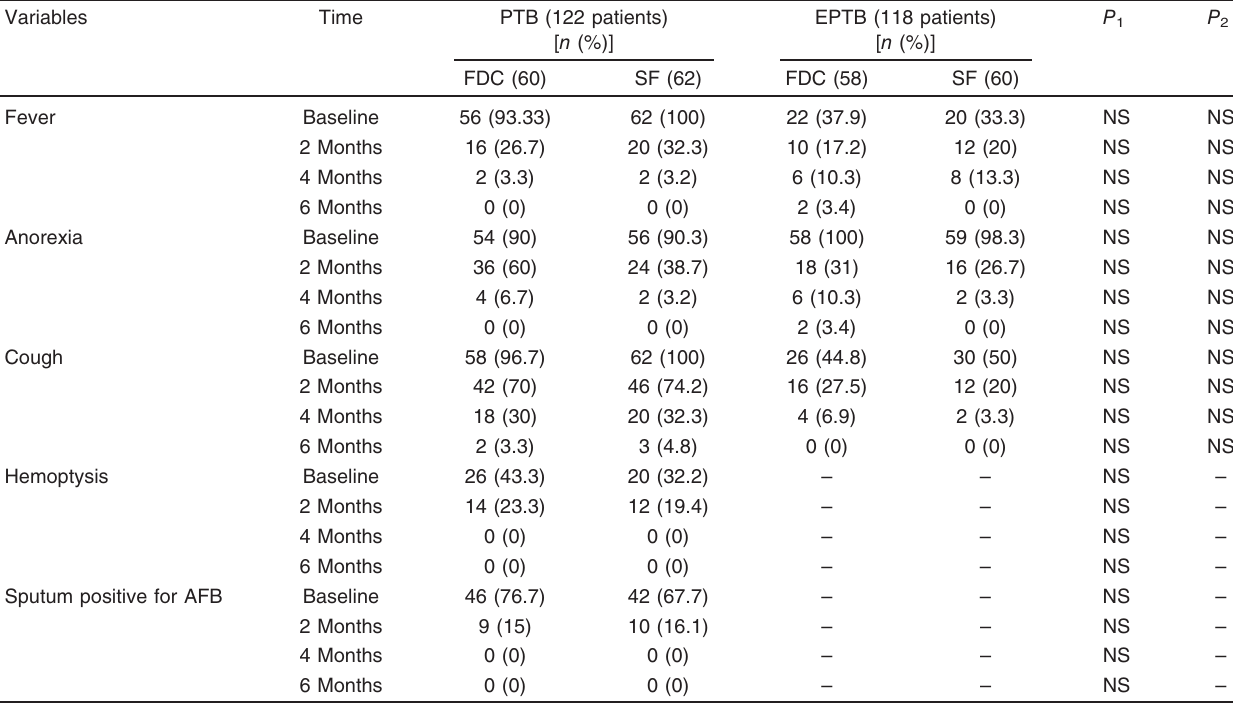
Table 2 Clinical data and sputum conversion of the studied groups during the course of treatment Variables